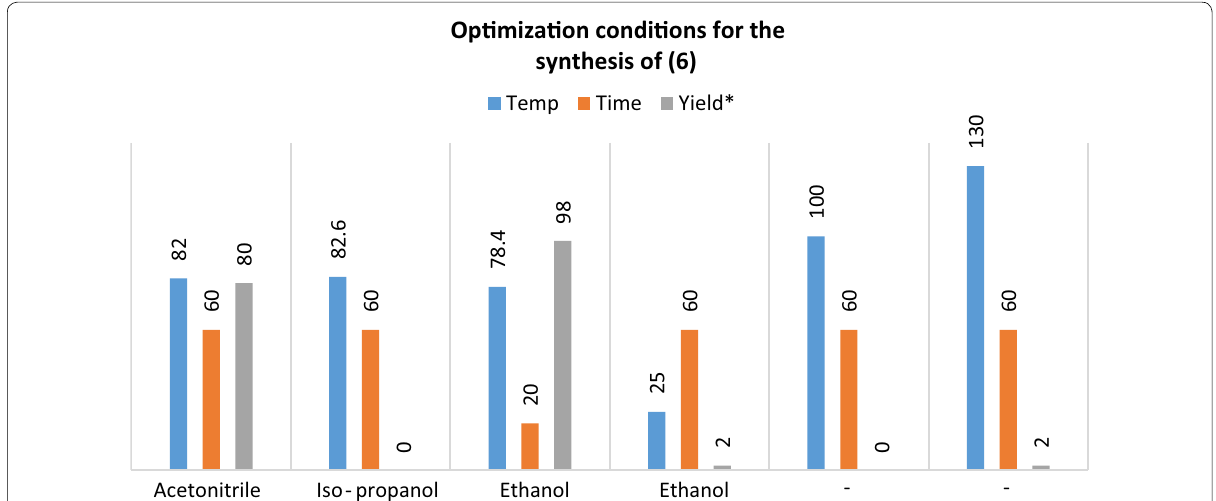
Fig. 2 Optimization conditions for the synthesis of ( 6 ). Reaction conditions: flunixin (1 mmol), meglumine (1 mmol). *The yields refer to the isolated product